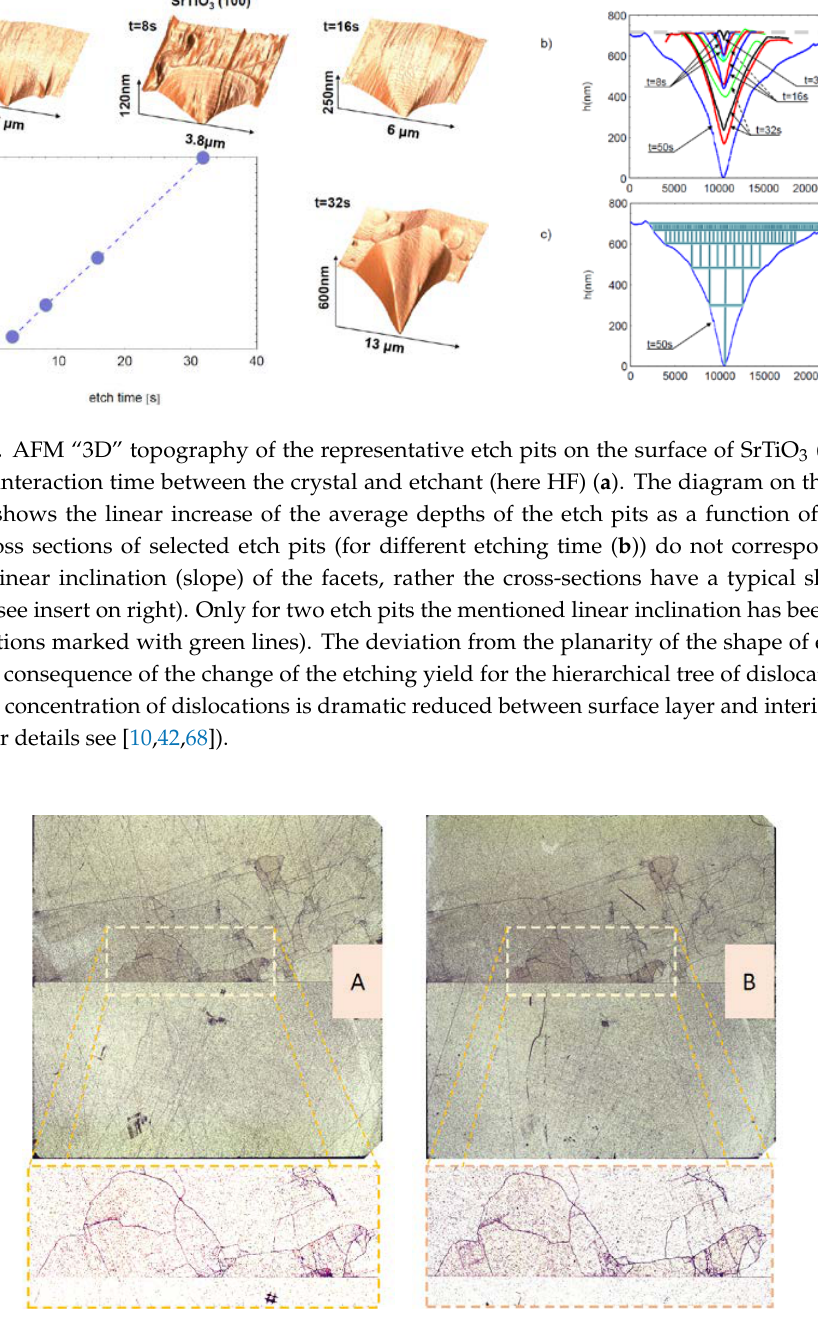
Figure 11. Distribution of etch pits on both sides ( A and B ) of a SrTiO 3 bicrystal (boundary 36.8°, dimension of the crystal 1 × 1 × 0.05 cm 3 ). The magnifications from the same regions of the crystals (upper and lower sides) show a similar position of the etch pits close to the boundary of the mosaic structure, which has been created during sythesis of the bicrystal. Notice: the photography B was mirrored.